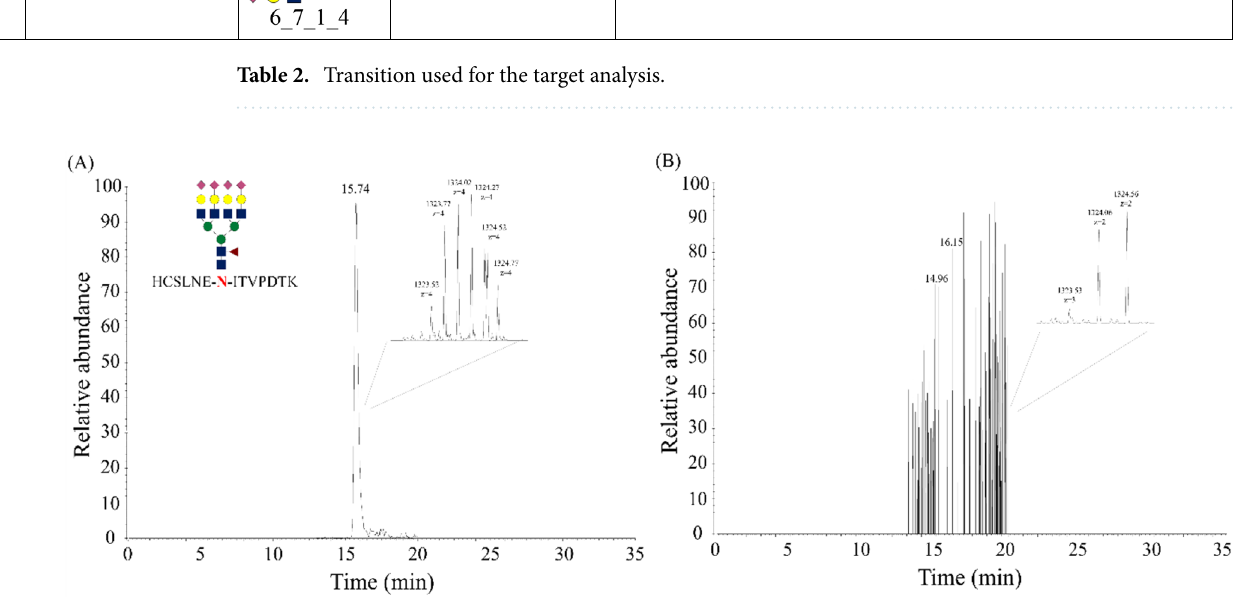
Figure 3. Target glycopeptide analysis using immunopurification. ( A ) Information about the target glycopeptide is provided. Red letters: N-glycosylation site. ( B ) Negative control